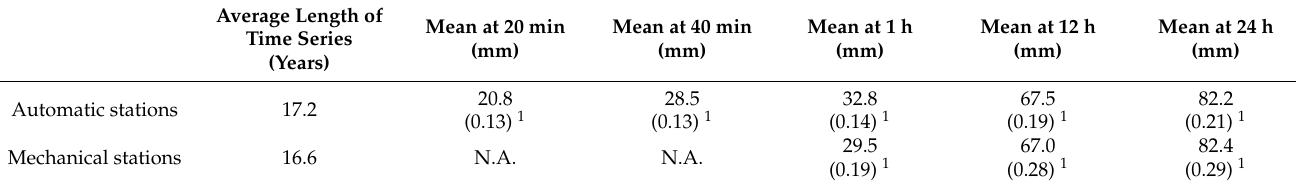
Table 1. Main statistics of mean annual maximum rainfall time